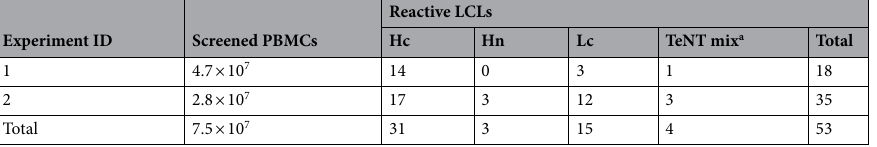
Table 1. Number of screened PBMCs and isolated LCLs. a TeNT mix is composed of Hc, Hn, and Lc proteins. The number of TeNT mix–reactive supernatants indicates refers to clones that were not reactive to Hc, Hn, or Lc individually but were reactive to the mixture of these three antigens in ELISA.